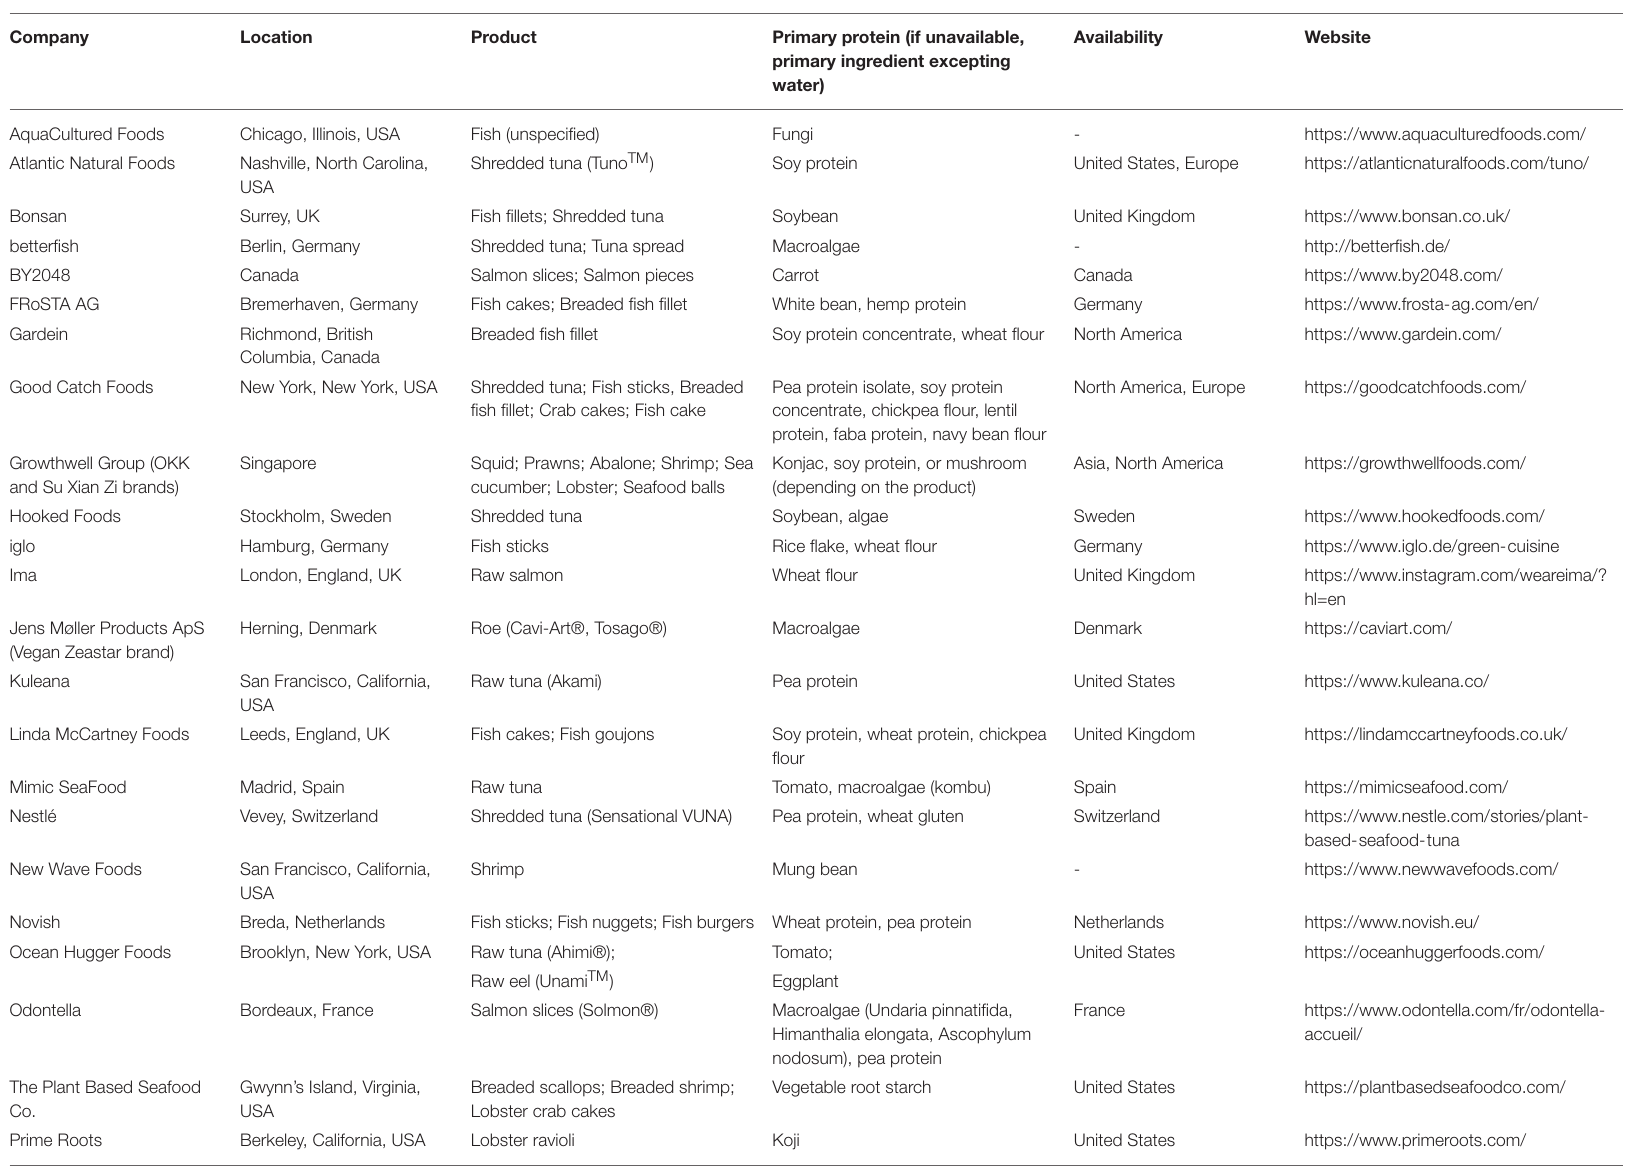
TABLE 1a | Current plant-based and fermentation-derived seafood producers, products, and main protein sources (as of 29 July 2021).